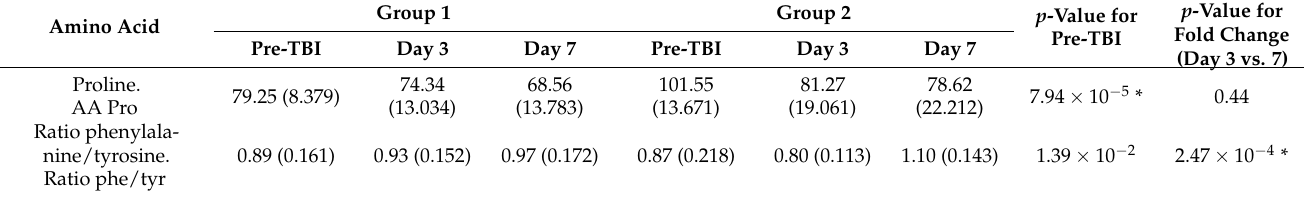
Table 2. Significant changes in amino acid levels in blood serum on days 3 and 7 after the TBI compared to the baseline. Note: Significant changes are marked with an asterisk.